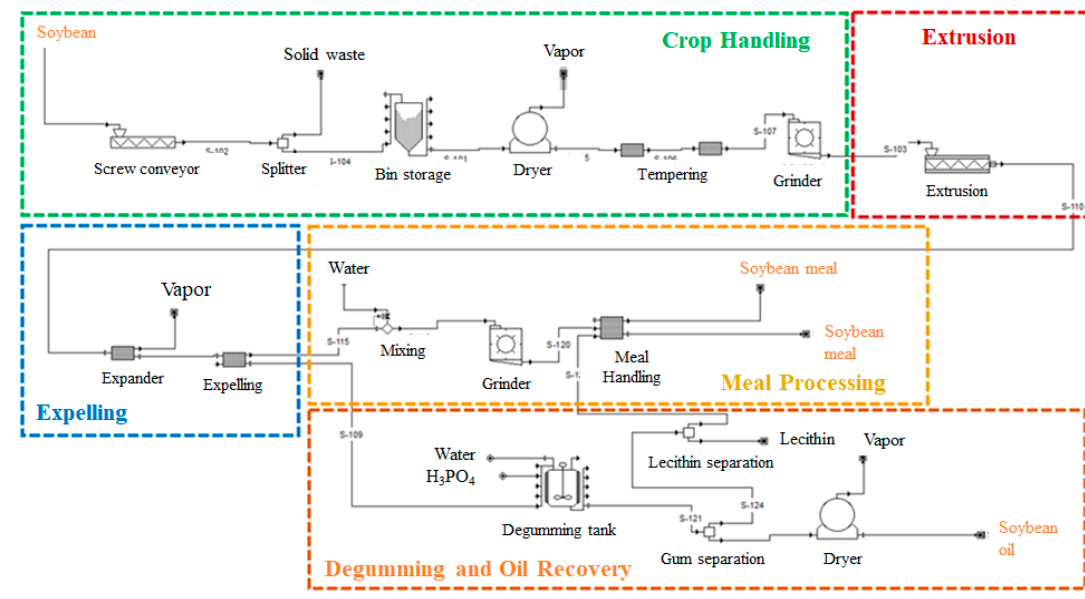
Figure 2. Flow diagram of soybean oil extruding-expelling TEA model.